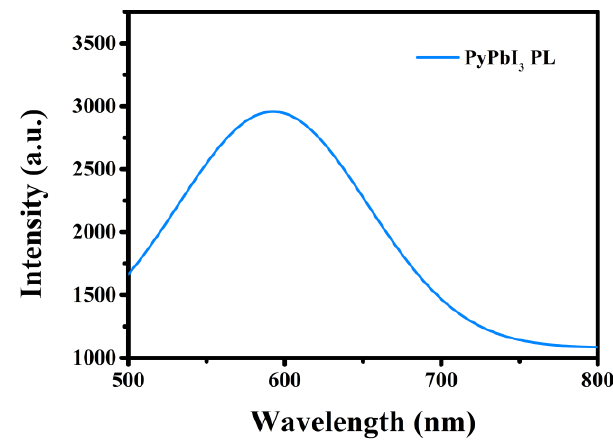
Figure 3. Steady state PL curve of PyPbI 3 .